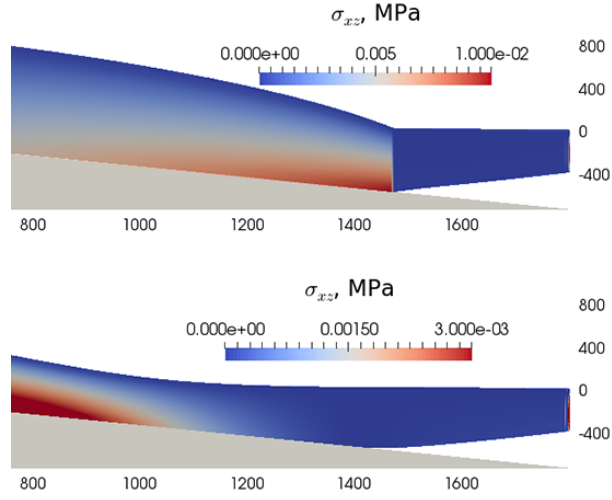
Figure 2. Stress tensor component σ xz shown at the end of the ADVA experiment for SR1 (top) and SR3 (bottom) for the seaward 1000km of the domain. At the base of the ice this approximates the basal shear stress, given the low slope of the bed. Note the differ- ent colour scales. Distance from the ice divide is shown along the bottom in kilometres. Height relative to sea level is shown at the right end of the plots in metres. Bedrock is shaded in grey. Vertical exaggeration is 200